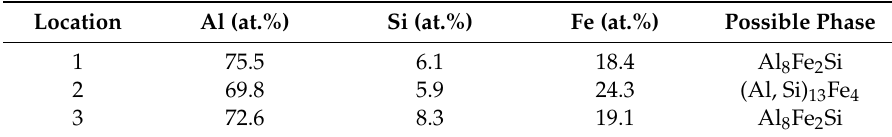
Table 3. EDS spot scanning results of zones 1–3 in Figure 4.